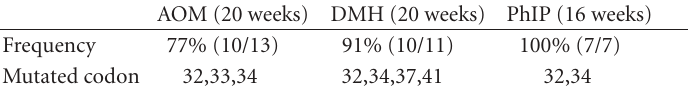
Figure 13: DSS is a powerful promoter in colon carcinogenesis in mice initiated with various colonic carcinogens, azoxymethane (AOM), 1,2-dimethylhydrazine (DMH), and 2-amino-1-methyl-6-phenylimidazo[4,5- b ]pyridine (PhIP) [12, 21–24,